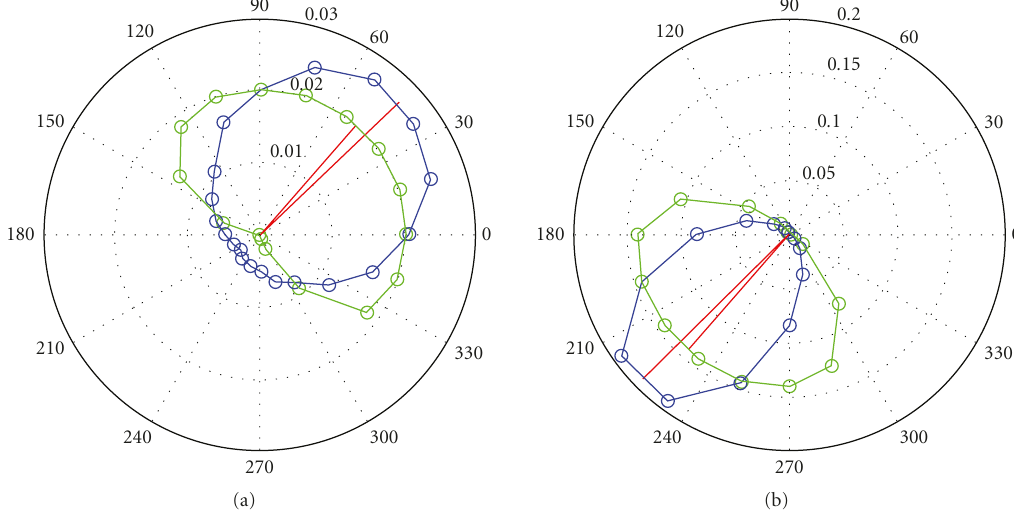
Figure 7: Tuned classes after clustering (two